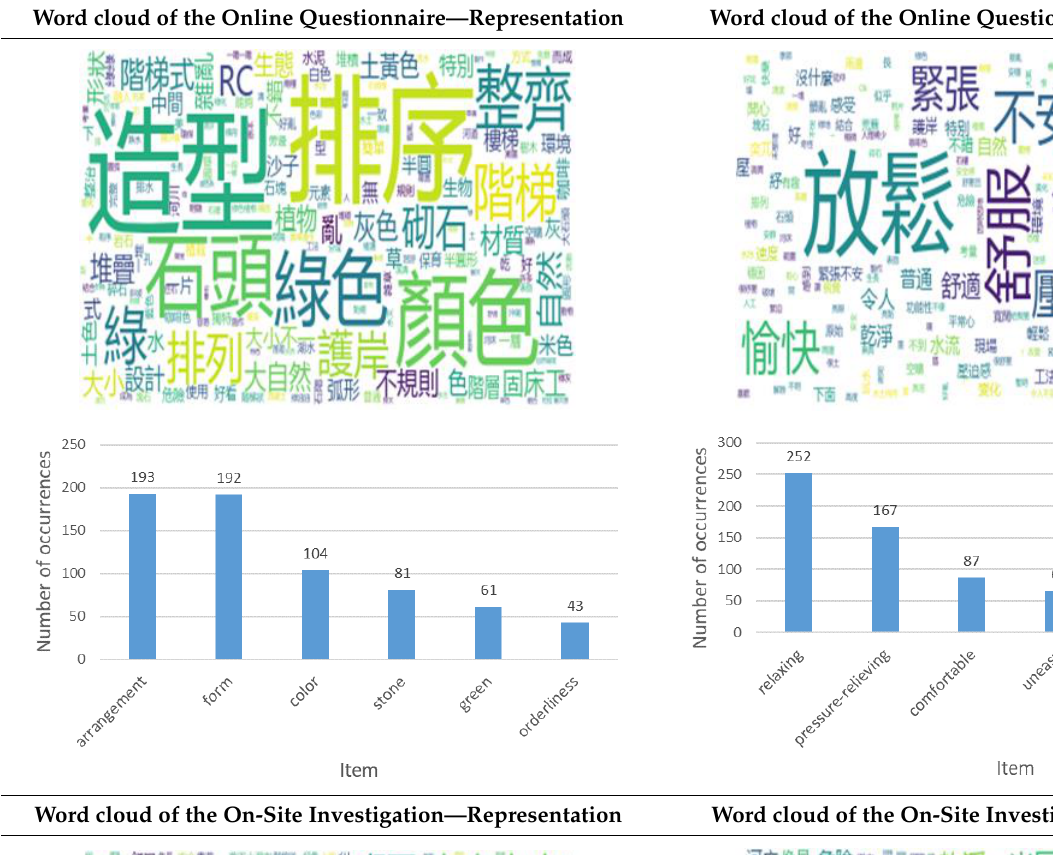
Table 5. Word cloud analysis of the “Upstream Renovation Project of Toubiankeng Stream in Zhongpu”.